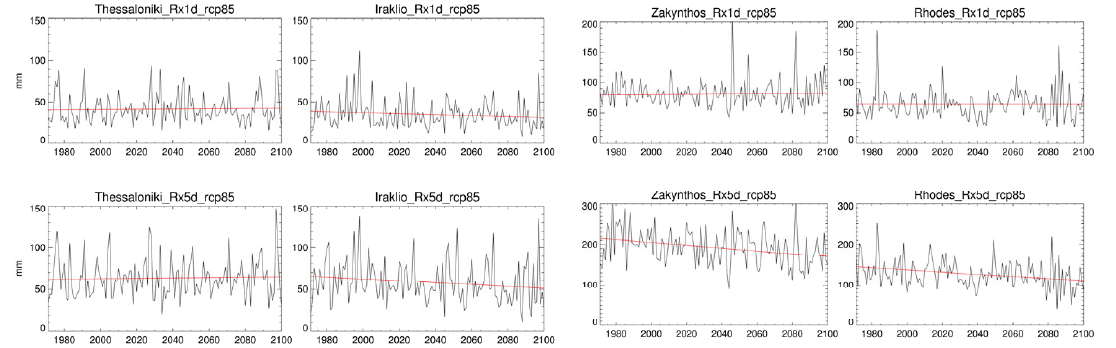
Figure 10. Annual maximum 1-day (Rx1d) and 5-day (Rx5d) precipitation totals during 1971–2100 in four Greek stations based on RCP8.5.